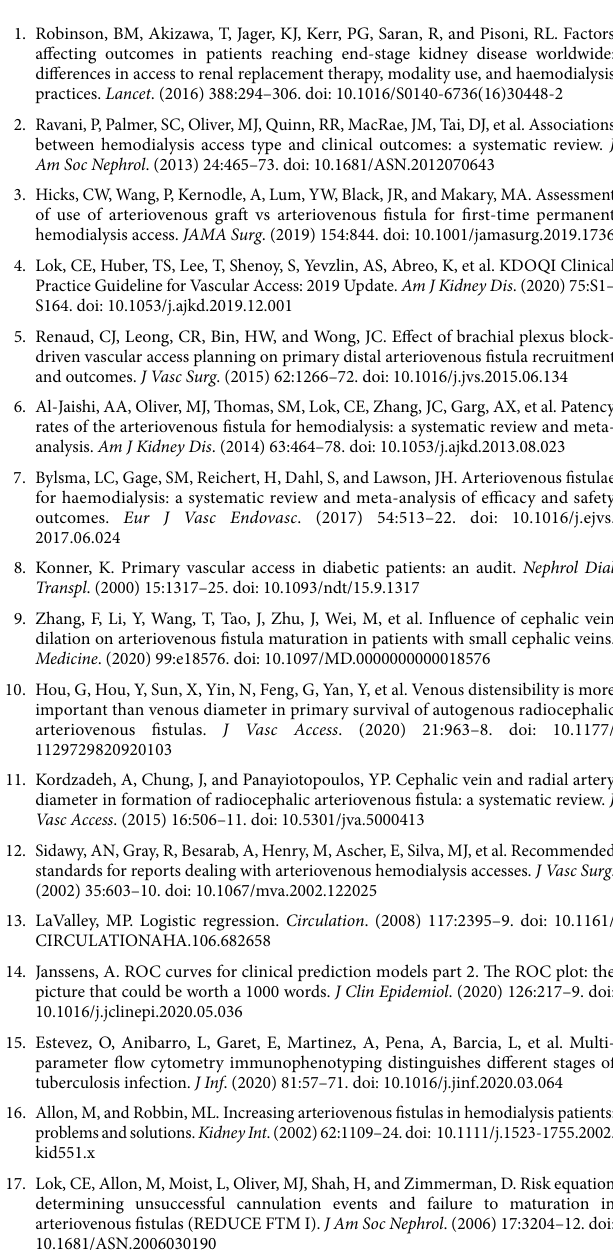
SUPPLEMENTARY FIGURE 1 Comparison of the primary (A) , assisted primary (B) and secondary (C) patency rates of the arteriovenous fistula (AVF) in different groups when vein diameter cut-off value was set at 2mm. P < 0.05 was considered statistical significance. SUPPLEMENTARY FIGURE 2 The different vein diameter distribution grouped by maturation time. Data are expressed as the mean ± SD and compared by two-tailed student’s t test between each two groups. The scattered points represented the specific vein diameter. The two horizontal lines above and below represent quartiles. P < 0.05 was considered statistical